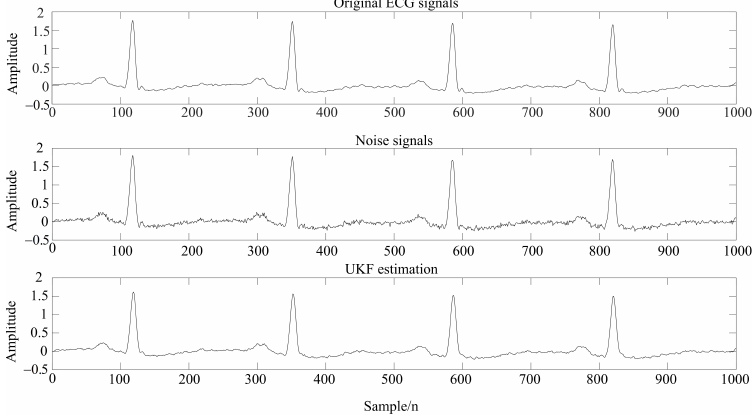
Figure 4. UKF filtering effect of ECG